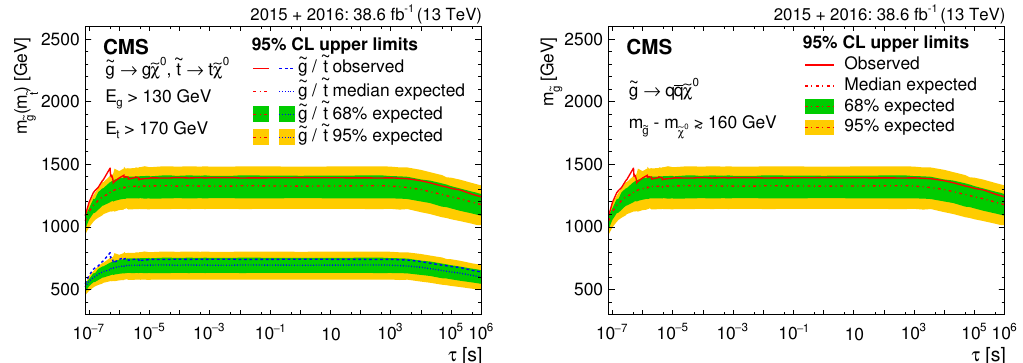
Figure 5 . The 95% CL upper limits on the gluino and top squark mass, using the cloud model of R-hadron interactions, as a function of lifetime, for combined 2015 and 2016 data for the calorimeter search. We show gluinos and top squarks that undergo a two-body decay (left) and gluinos that undergo a three-body decay (right). The discontinuous structure observed between 10 (cid:0) 7 and 10 (cid:0) 5 s is due to the increase of the number of observed events in the search window as the lifetime